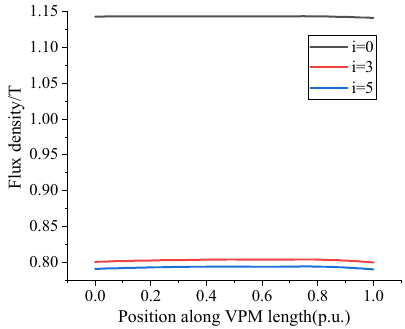
Figure 18. Air gap flux density of the motor under different excitation currents. ( a ) Waveform of air gap flux density; ( b ) harmonic spectra.